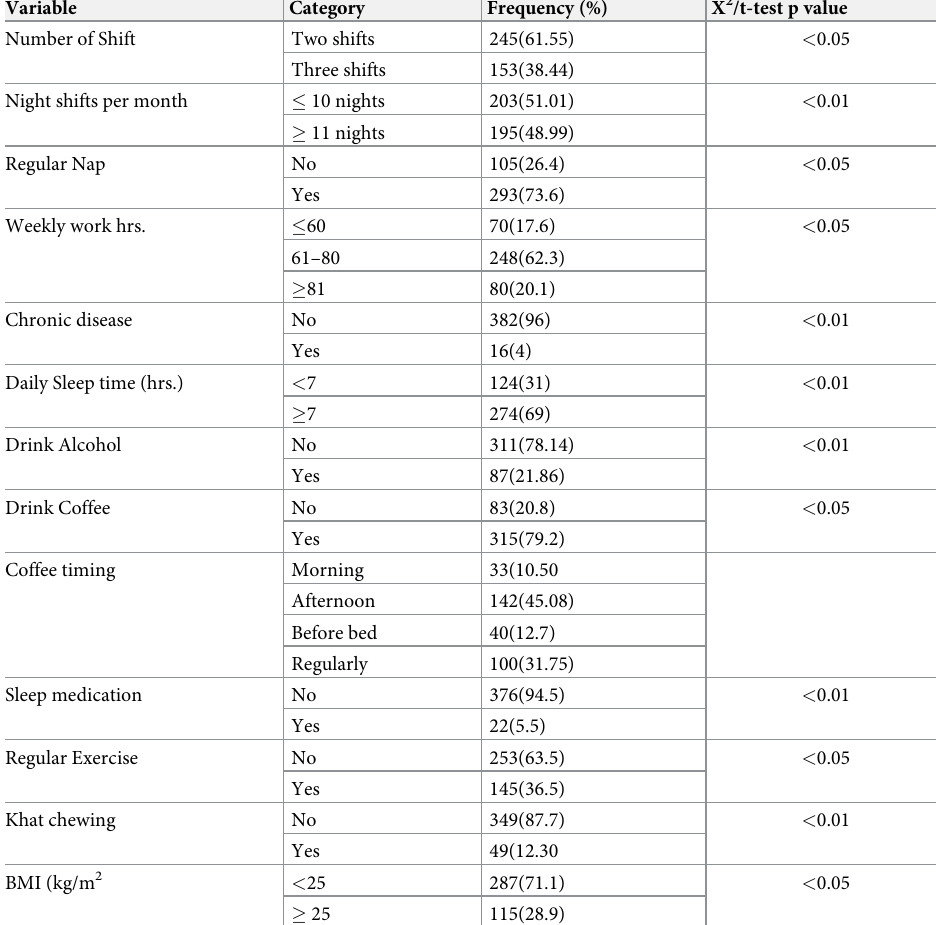
Table 2. Sleep health and substance use behavior related characteristics of HCWs working at public hospitals in Sidama national regional state, Southern Ethiopia, 2021 (N =